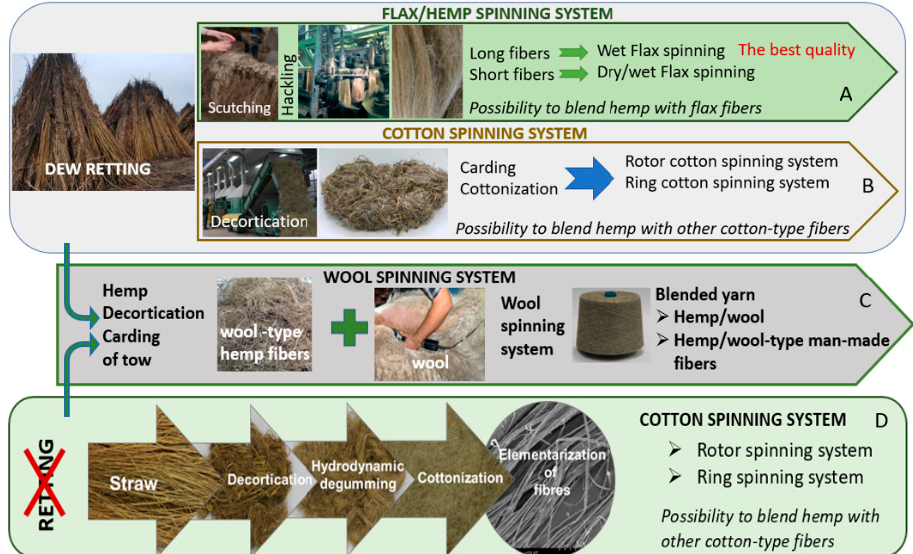
Figure 18. Graphical performance of process chains possible to use for hemp yarn production. A—